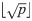
Error rate estimates for the binary power case study (balanced).Shown are different error rate estimates for the setting with two response classes of equal size and with both predictors with effect and without effect. The error rate was estimated through the test error, the OOB error, the stratified OOB error, the CV error, and the stratified CV error for settings with different sample sizes, n, and numbers of predictors, p. The mean error rate over 500 repetitions was obtained for a range of mtry values. The vertical grey dashed line in each plot indicates the most commonly used default choice for mtry in classification tasks, that is ⌊p⌋.